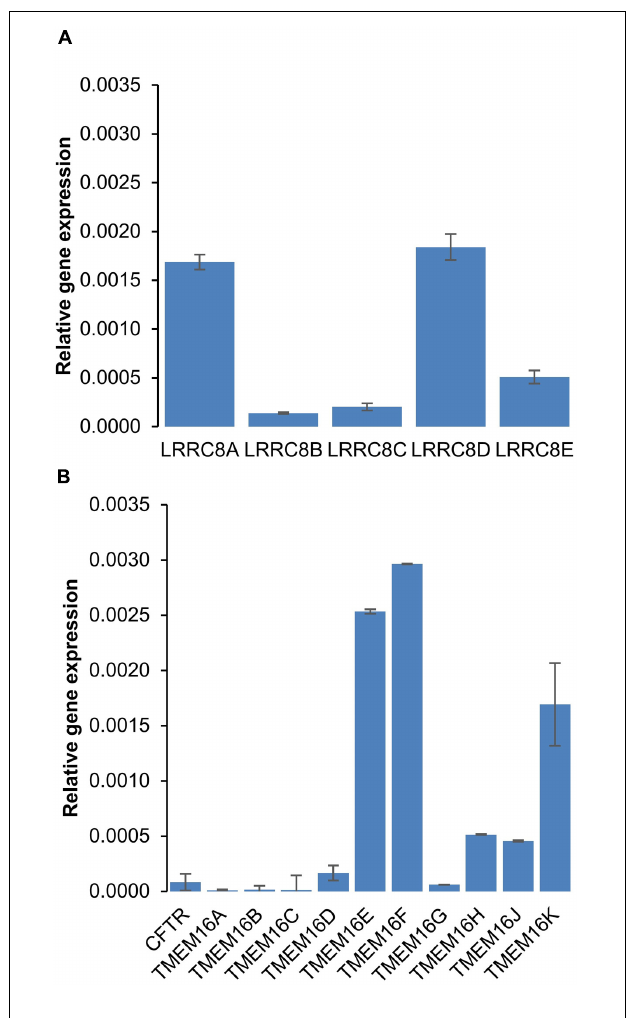
FIGURE 1 | mRNA expression of chloride channels in HEK-293 cells. (A,B) Quantitative RT-PCR was used to measure the mRNA expression levels of LRRC8 subunits (A) and of the CFTR and TMEM16 families (B) compared to 36B4. The experiments were performed using 3 different cell cultures obtained from 3 different passages. The reported values are the mean ± SEM of 9 independent quantitative RT-PCR